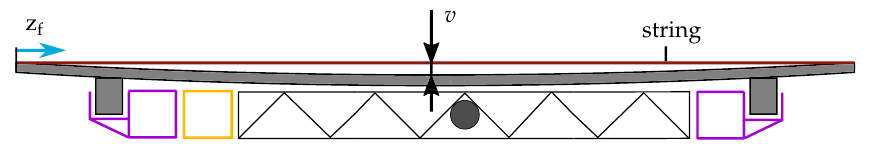
Figure 12. Experimental setup for deflection measurement of the flap by a rotation around x-axis. Figure 13 shows the shape of the flap with a rotation of the Stewart platform around the x-axis (see Figure 9). The reference shape emerges when the flap was initially mounted to the end effector. In order to mount the flap it hangs on a crane as depicted in figure 4 and the end effector is moved below the flap. The fixed side of the end effector is bolted to the flap first. In the second step the Stewart platform moves in order to align the bolt holes at the moveable side. Therefor the flap is not free from internal stresses in the reference shape. In order to determine the maximum possible bending of the flap with the Stewart platform used, the platform is rotated around the x-axis in positive and negative direction until the actuators generate their maximum bending moment. It can be seen, that the flap can’t be bend by negative rotation.